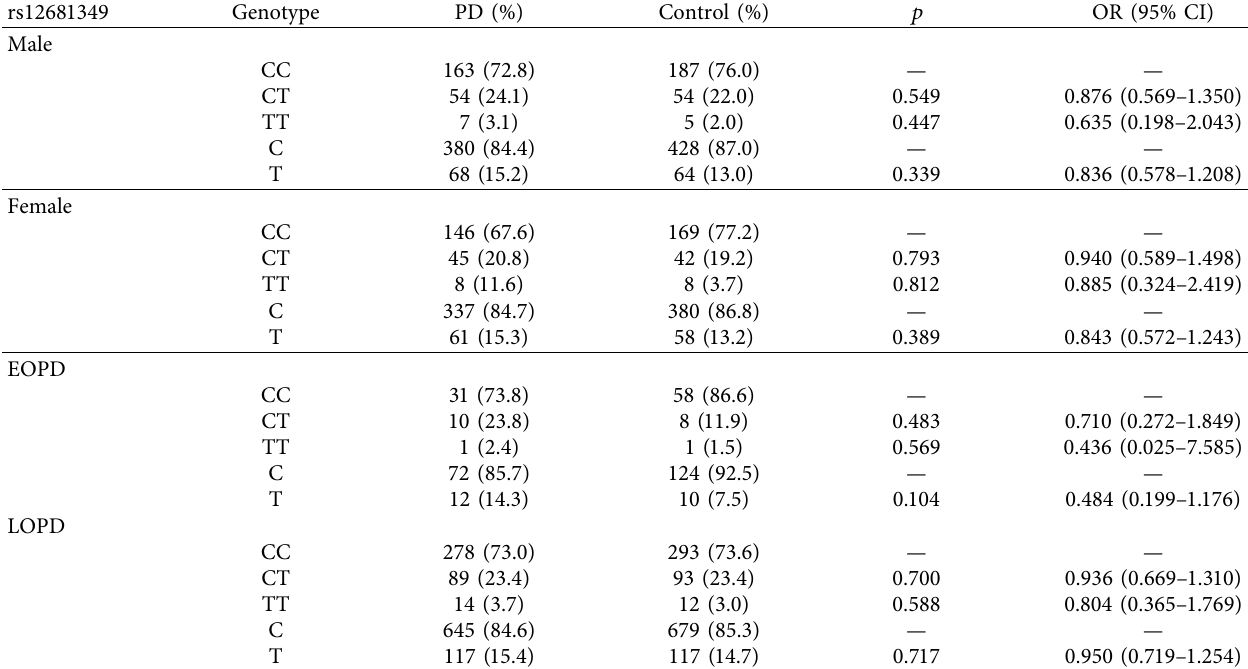
Table 7: Distributions of rs12681349 polymorphism different subcomponent